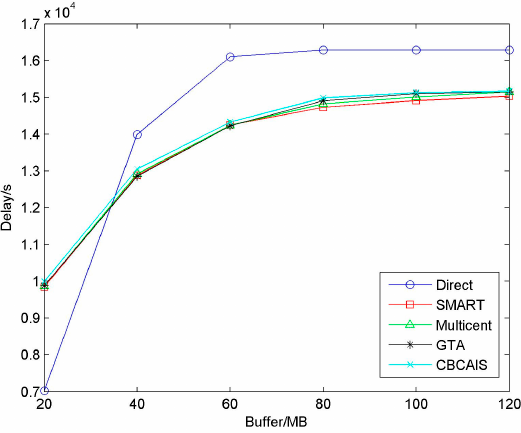
Figure 10. Delivery delay for varying buffer size.